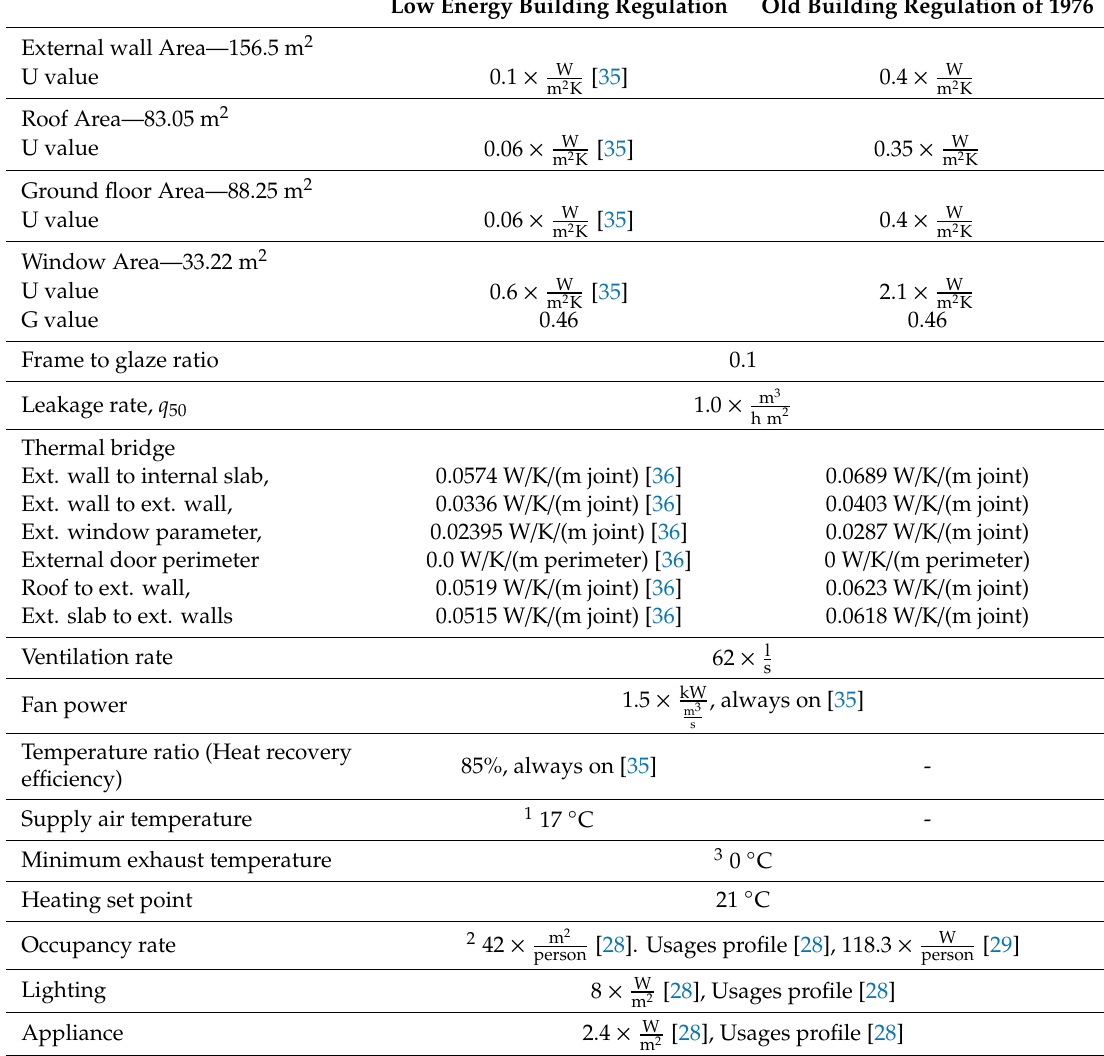
Table 1. A detailed description of input data for a reference building